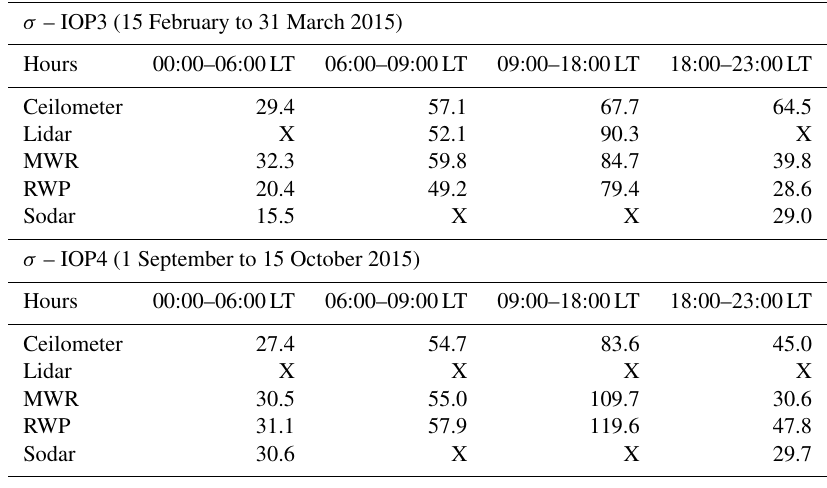
Table 3. Standard deviation calculated for PBL height measurements of instruments at different intervals of the daily